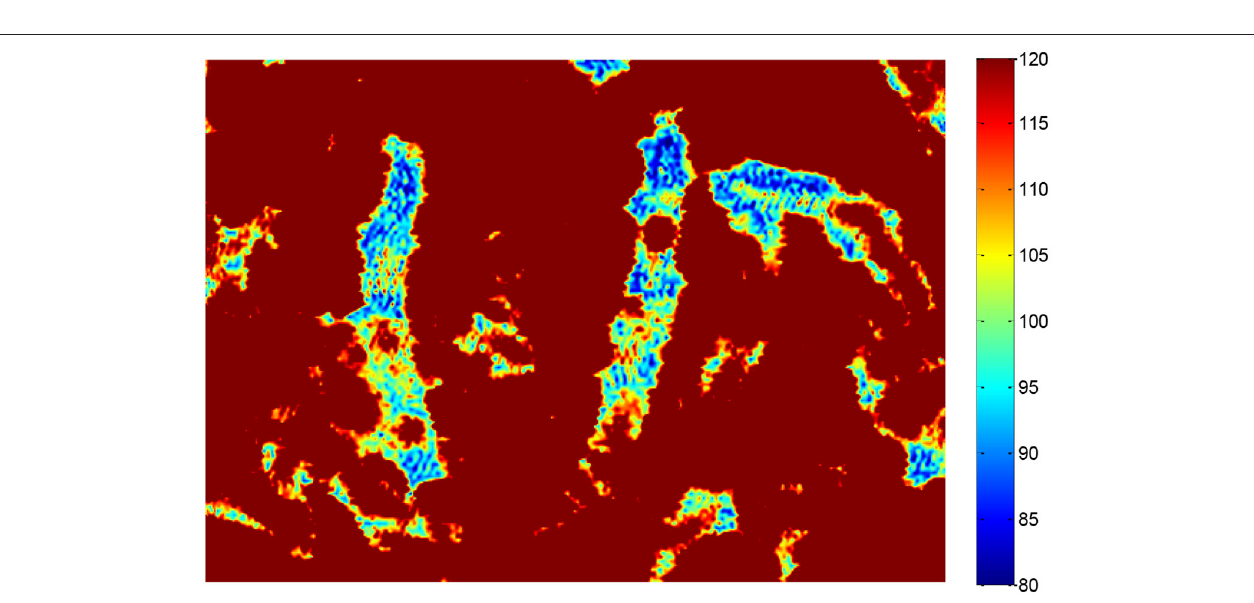
FIGURE 8 | False color image for THz reflection imaging (2,480 × 3,509 pixels) with grayscale values adjusted from 80 to 120.